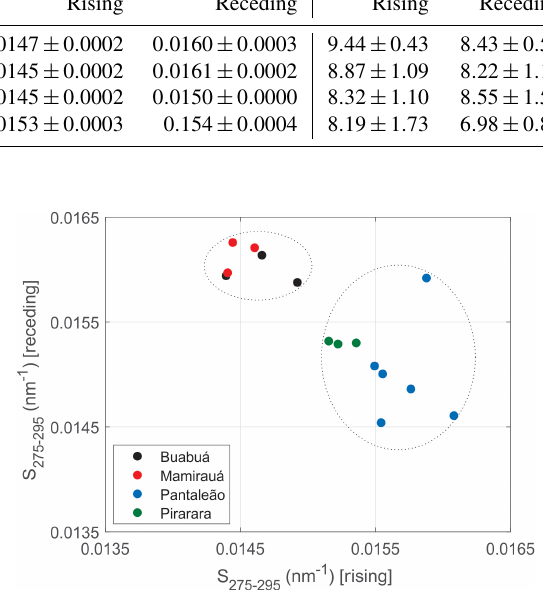
Figure 4. Dispersion diagram of average S 275–295 (nm − 1 ) at each hydrograph stage (rising and receding) and in all lakes. The dotted ellipses represent the two groups